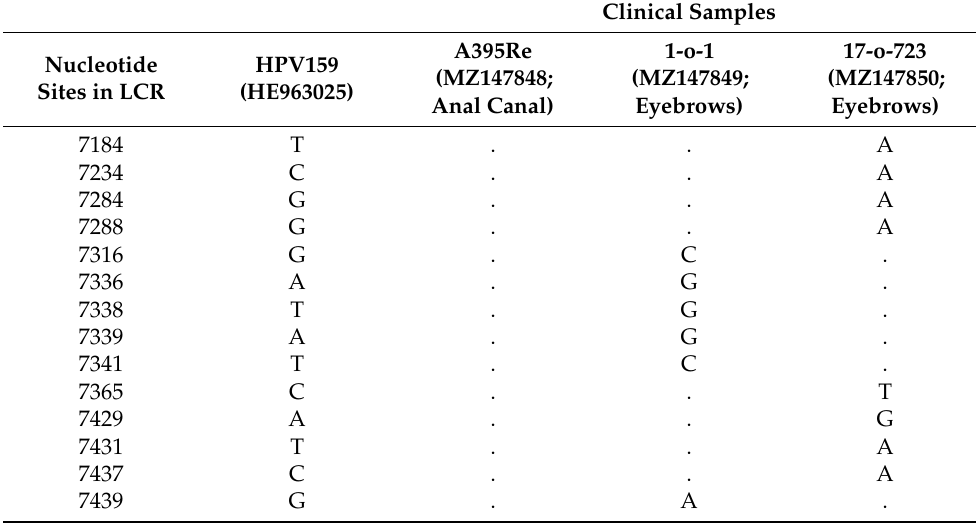
Table 4. HPV159 long control region viral variants identified in three HPV159-positive clinical samples (two eyebrow hair follicles and one anal swab). The nucleotide sites of the HPV159 reference isolate (GenBank acc. no. HE963025) at which nucleotide alterations occurred in the clinical samples are marked at the top of the table. Genomic sites where no changes were observed are marked with a